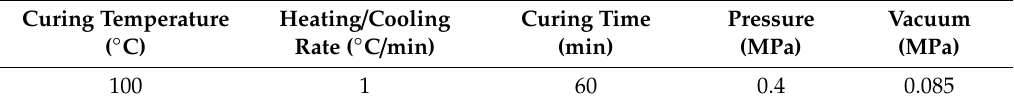
Table 1. Autoclaving process parameters.